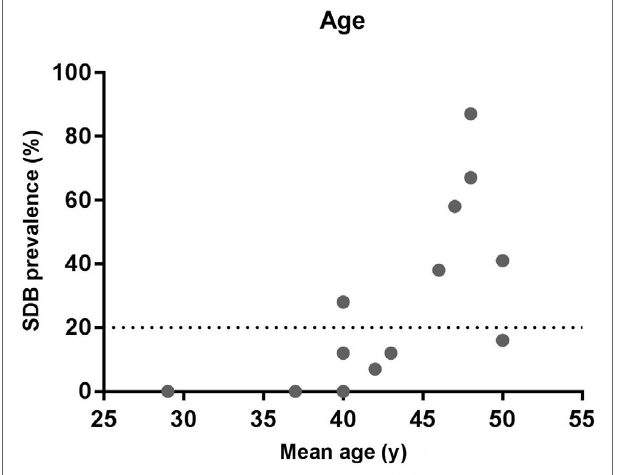
FigURe 3 | Relationship between sleep-disordered breathing (SDB) prevalence and expanded disability status scale score (EDSS). The data show the prevalence of SDB and the mean EDSS scores from the studies listed in Table 1 .